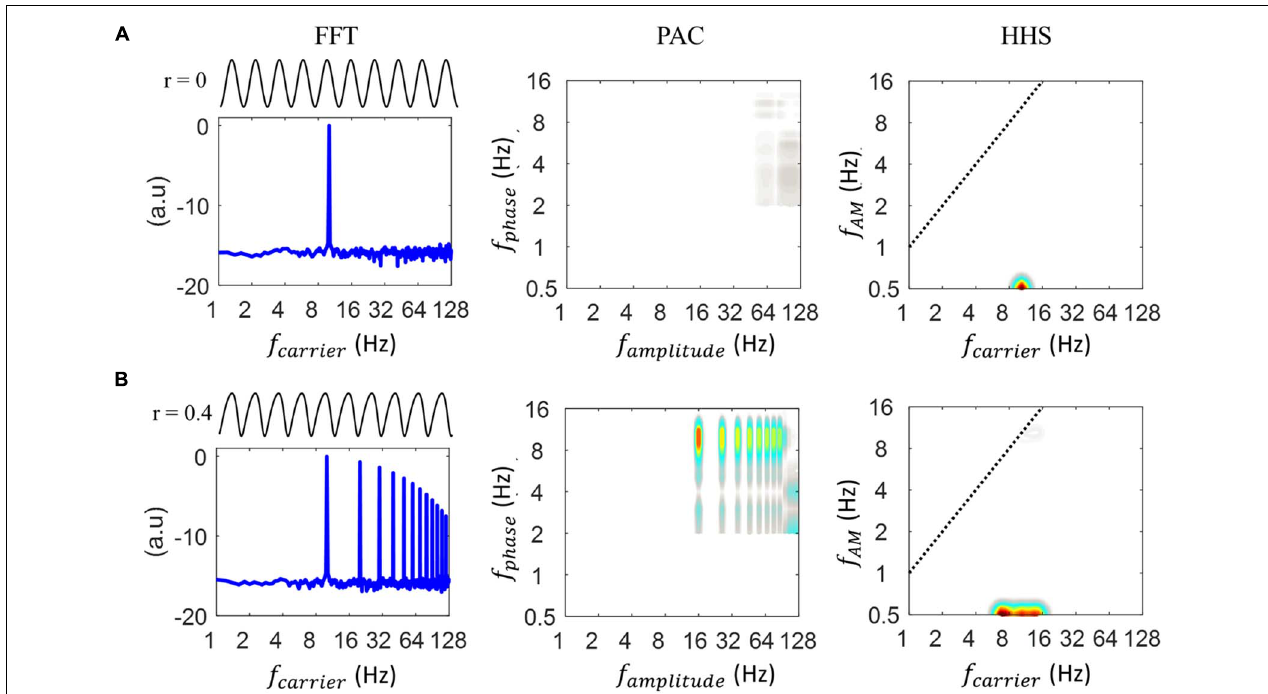
FIGURE 3 | Illustration of how the shape of the waveform alters the resulting phase-to-amplitude comodulogram for different analyses. (A) Starting from the left, the first panel shows the 10 Hz sinusoidal oscillation and its FFT. The FFT spectrum shows an amplitude at 10 Hz. Next is shown the PAC comodulogram, estimated by the Modulation Index and finally, the Holo-Hilbert spectrum of the input oscillation is shown. The latter spectrum showed an amplitude increase centered at a 10 Hz carrier without producing harmonics. (B) Starting from the left, the first panel shows the 10 Hz non-sinusoidal oscillation, which does not contain any coupling. The FFT spectrum showed an amplitude at 10 Hz and its harmonics. Next, the PAC comodulogram, estimated by Modulation Index, indicated coupling between the 10 Hz phase and 20, 40, and 128 Hz amplitudes, which are all spurious PAC couplings. The Holo-Hilbert spectrum of the input oscillation showed a wider amplitude increase centered at the 10 Hz carrier frequency without any induced